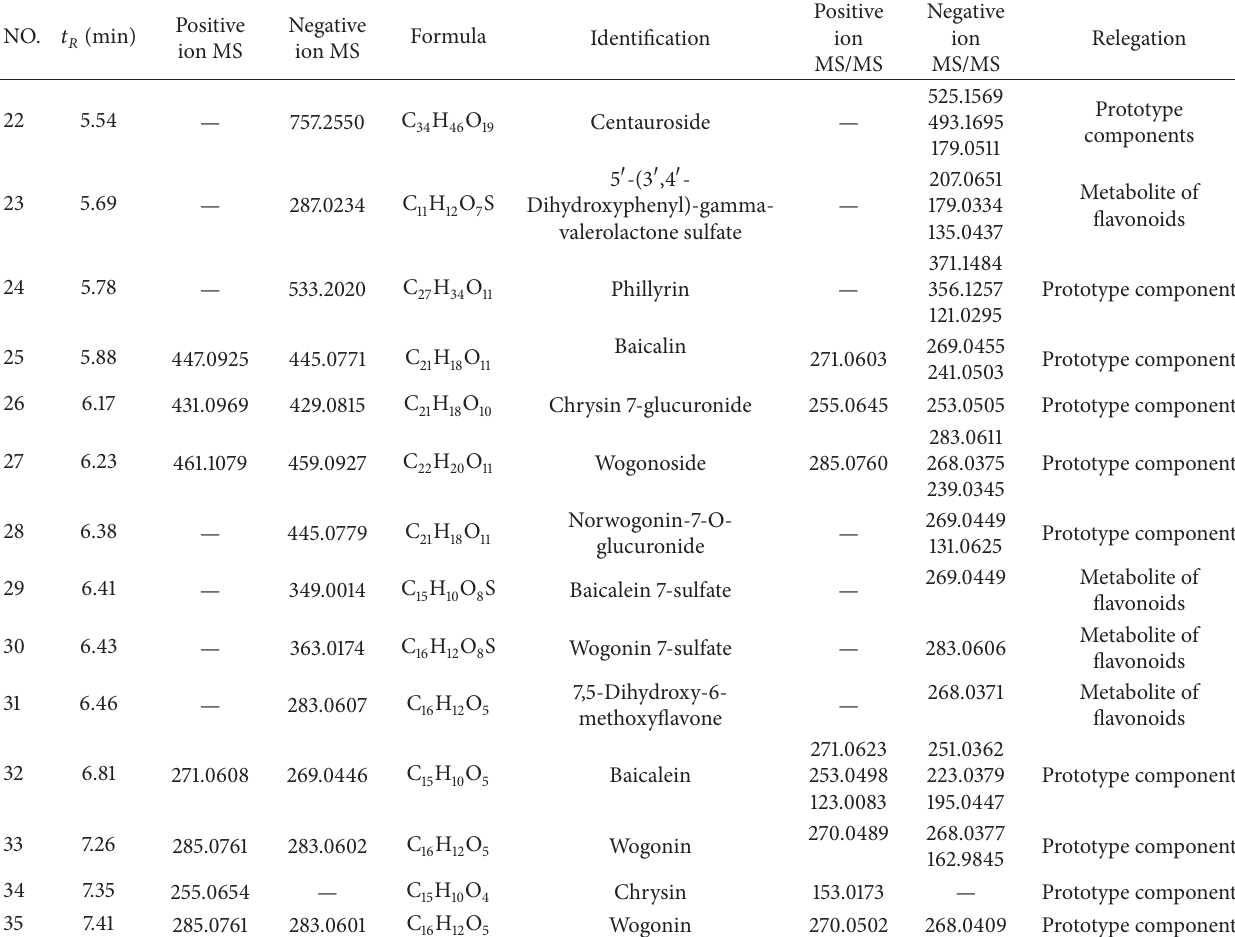
Figure 5 showed the visualized trend plot of 7.41-285.0762 in positive mode between C group and SHLI group. The ion only appeared in the SHLI group. Therefore, 7.41- 285.0762 might be a prototype component or a metabolite